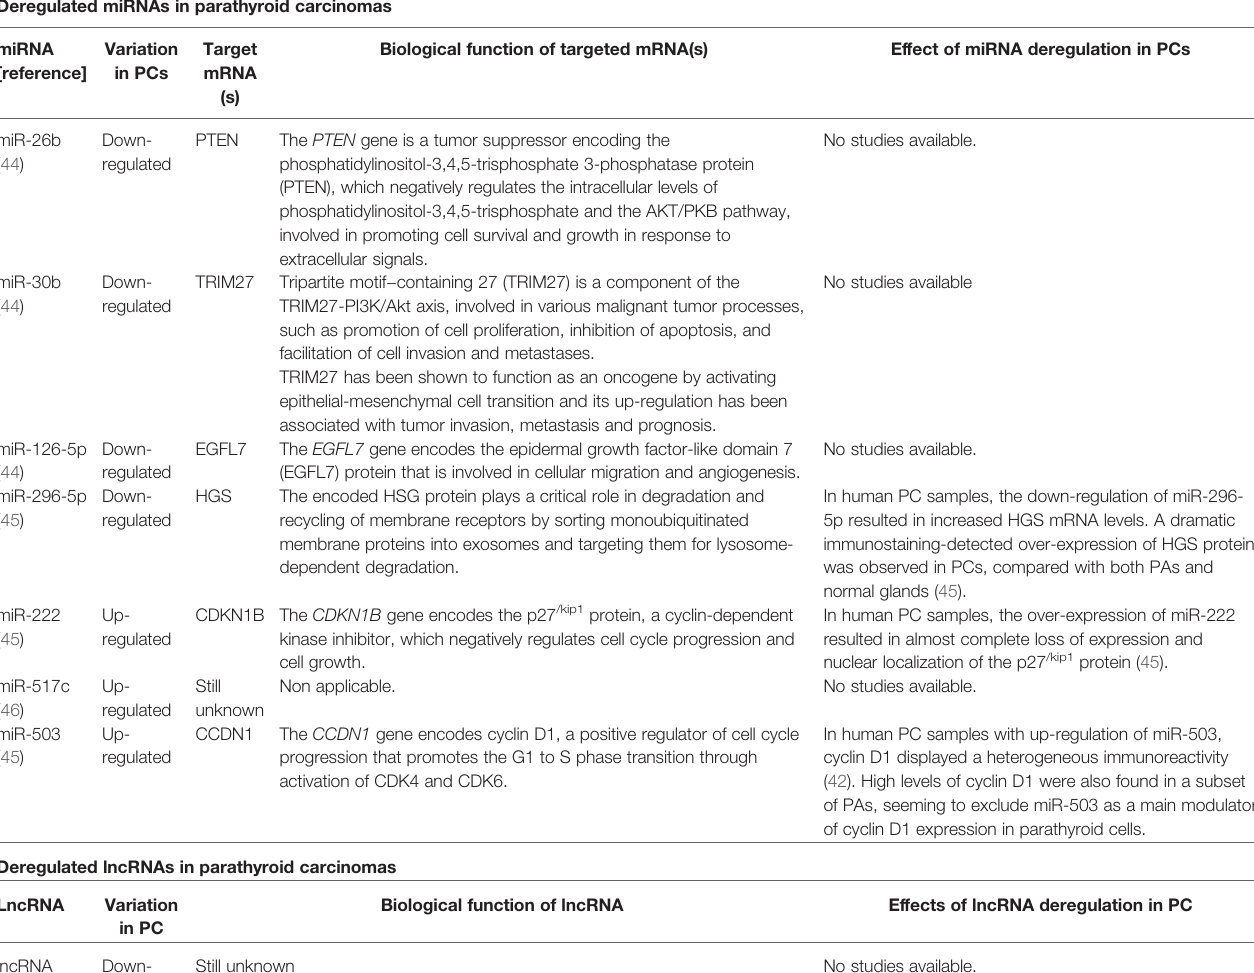
TABLE 3 | Deregulated miRNAs and lncRNAs in parathyroid carcinomas. Deregulated miRNAs in parathyroid carcinomas miRNA Variation [reference] in